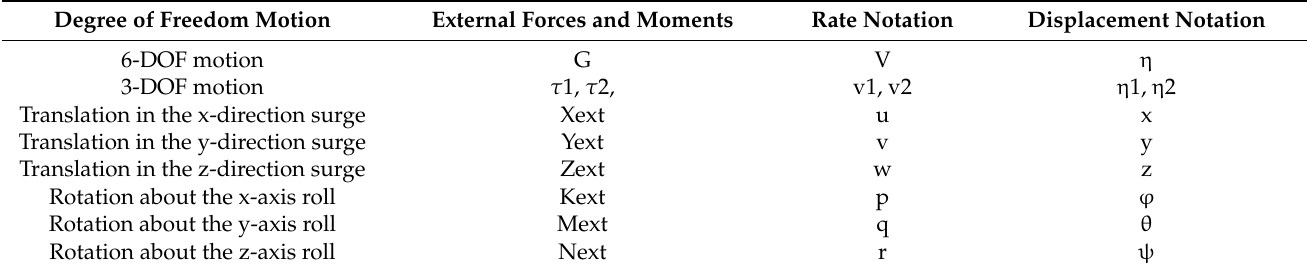
Figure 1. AUV motion in 6-DOF AUV. Table 1. Notations notation used for